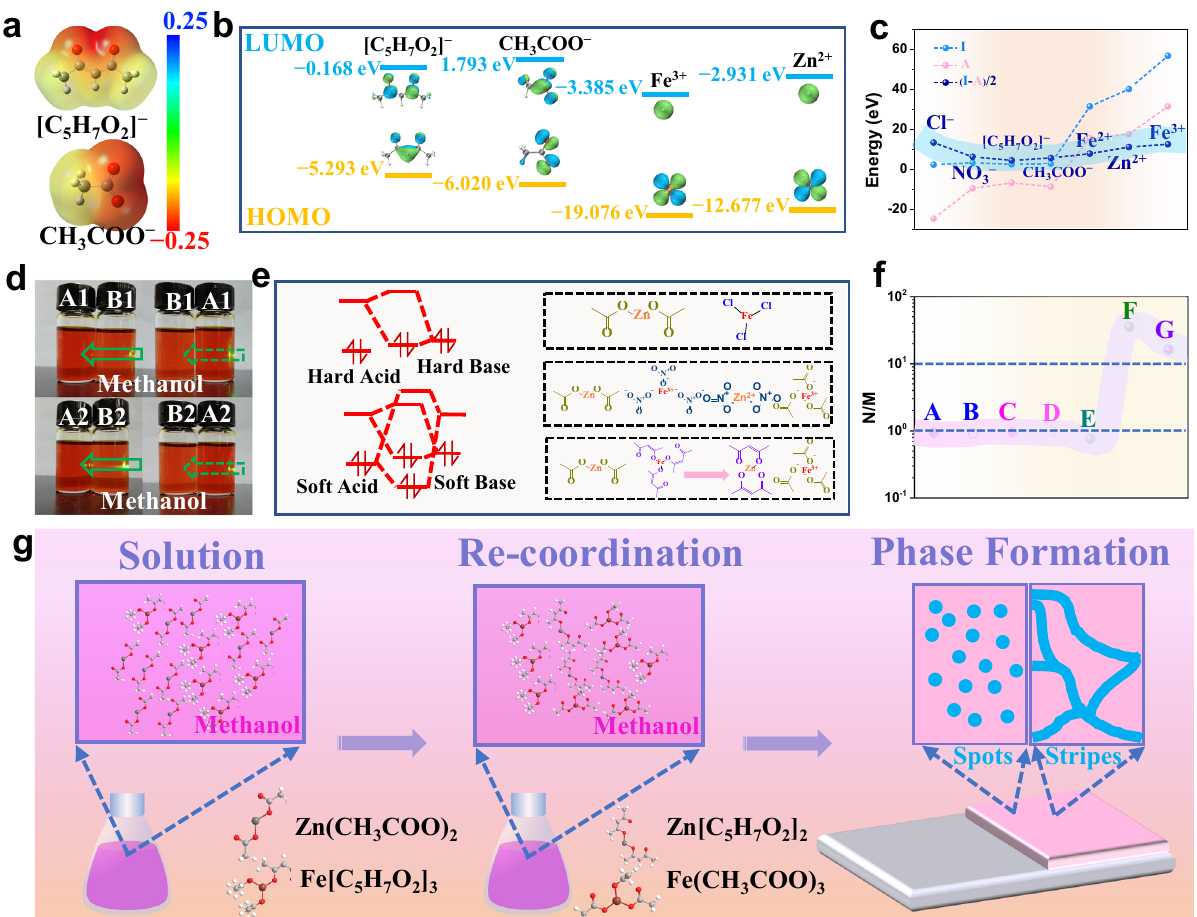
Fig. 2 Hard-Soft-Acid-Base (HSAB) theory. a Molecular electrostatic potential surface of CH 3 COO − and [C 5 H 7 O 2 ] − . b Frontier molecular orbitals for [C 5 H 7 O 2 ] − , CH 3 COO − , Fe 3 + and Zn 2 + obtained by the B3LYP/6-311 G (d, p) method. c The ionization energy and electron af fi nity. d The solution exhibits an obvious Tyndall effect upon the addition of the same concentration of acetate ions (A1: 10 mg Fe[C 5 H 7 O 2 ] 3 , 4.5 mL methanol; B1: 7 mg Ba(CH 3 COO) 2 , 10 mg Fe[C 5 H 7 O 2 ] 3 , 4.5 mL CH 3 OH; A2: 10 mg Fe[C 5 H 7 O 2 ] 3 , 4.5 mL methanol; B2: 5.2 mg CH 3 COOK, 10 mg Fe[C 5 H 7 O 2 ] 3 , 4.5 mL methanol). e Ion exchange reaction based on the HSAB theory. f Ratio of diffusion coef fi cients (Supplementary Fig. 15, for FeCl 3 , A is Zn: Fe = 1:3 and B is Zn: Fe = 1:4; for Fe(NO 3 ) 3 , C is Zn: Fe = 1:3 and D is Zn: Fe = 1:4; for Fe[C 5 H 7 O 2 ] 3 , E is Zn: Fe = 1: 2, F is Zn: Fe = 1:3, and G is Zn: Fe = 1:4). g Schematic diagram of Turing structure formation (spots or